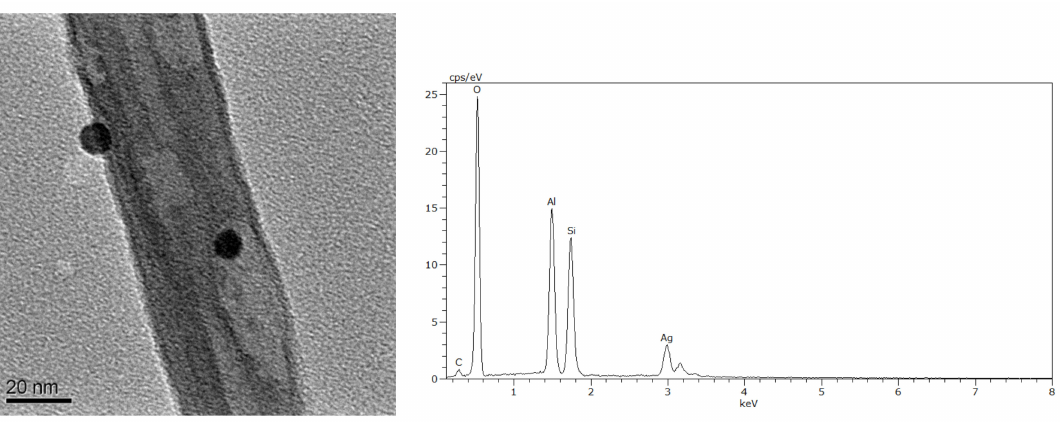
Figure 1. Transmission electron microscopy (TEM) and energy dispersive X-ray spectroscopy (EDS) images of the Ag / Halloysite.